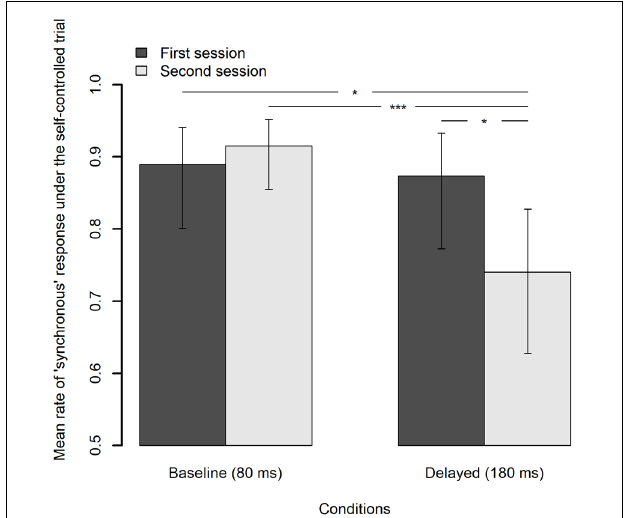
FIGURE 6 | Mean rate of “synchronous” response under the self-controlled trials for each feedback delay and each session, in which the feedback delay is fixed to 80 ms. The error bar represents 95% confidence interval of the mean. * p < 0.05, *** p <